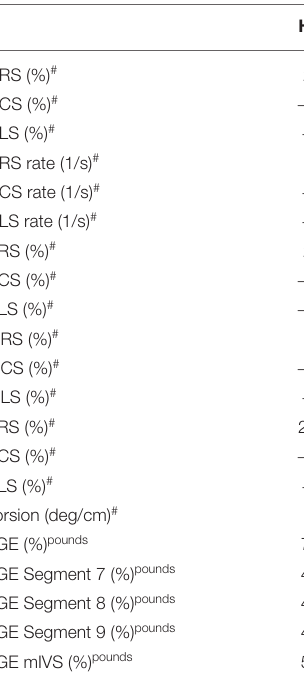
TABLE 2 | CMR strain and LGE data of the study